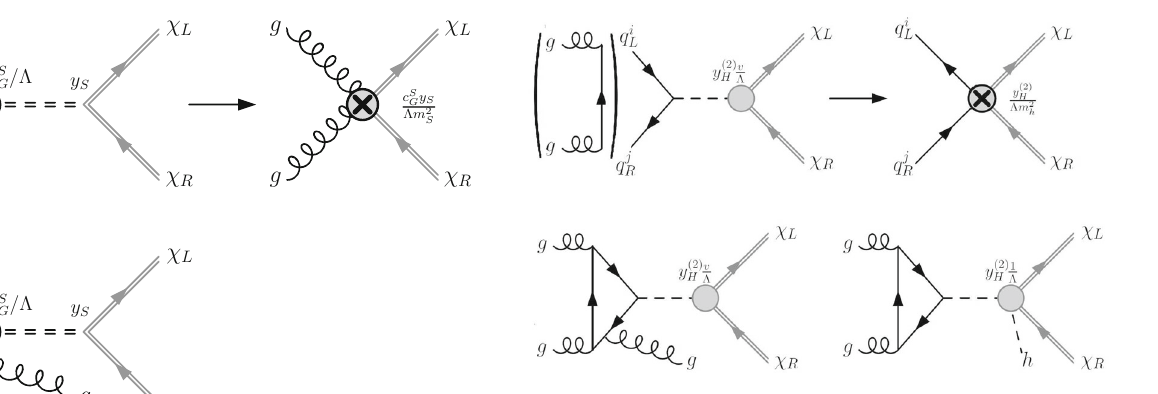
Fig. 4 Relevant diagrams contributing to nuclear interaction with fermionic DM (first row) and corresponding DM observables at hadron colliders (monojet and Higgs + / E T , second row), turning on the inter- ( 2 ) action ∼ y and G